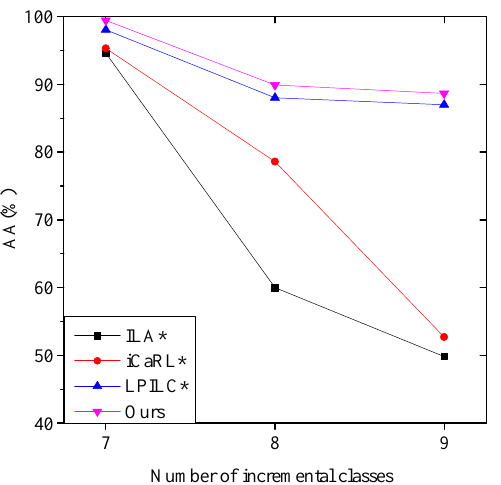
Figure 13. Comparison AA of PaviaU with other methods (ILA [58], iCaRL [48], LPILC [55]) when adding a new